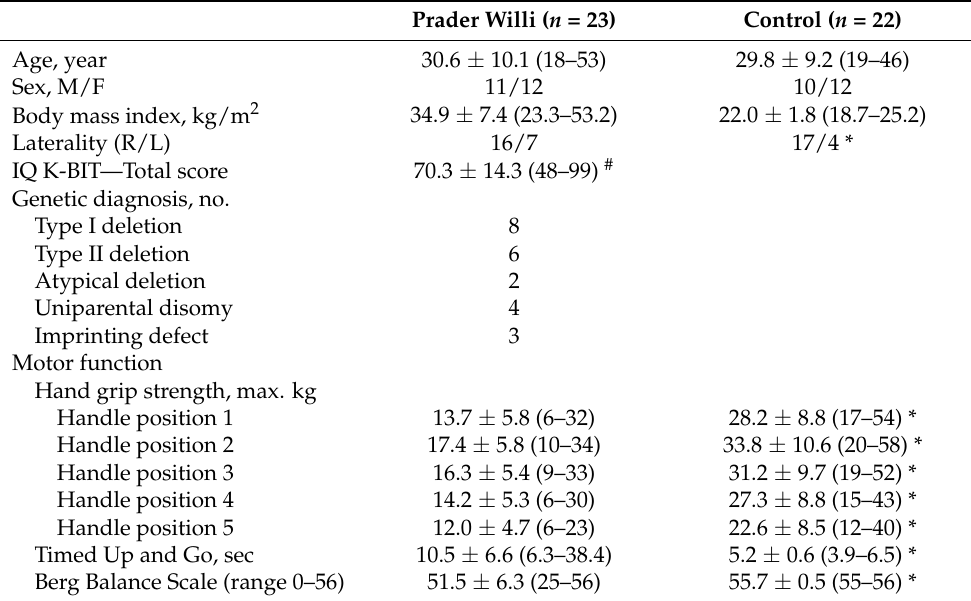
Table 1. Demographic and clinical characteristics of study